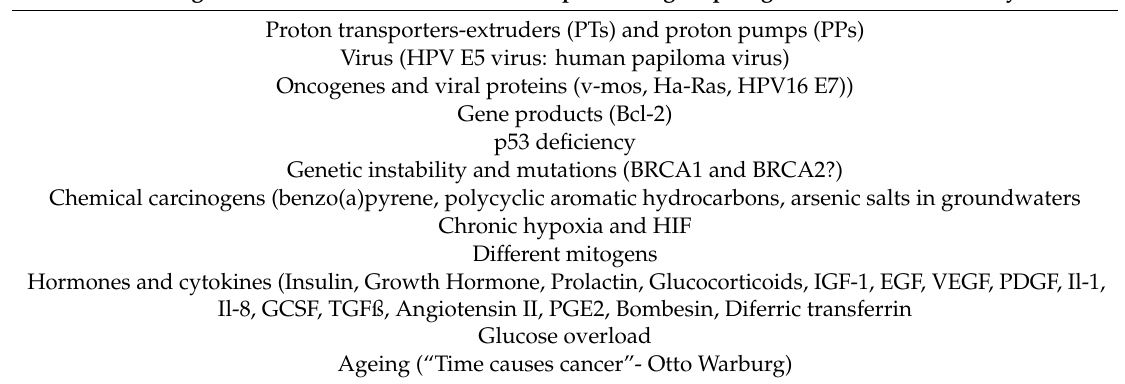
Table 1. This Table (modified and updated from ref [49]) shows some carcinogenic factors that increase cellular pH through up-regulation of NHE